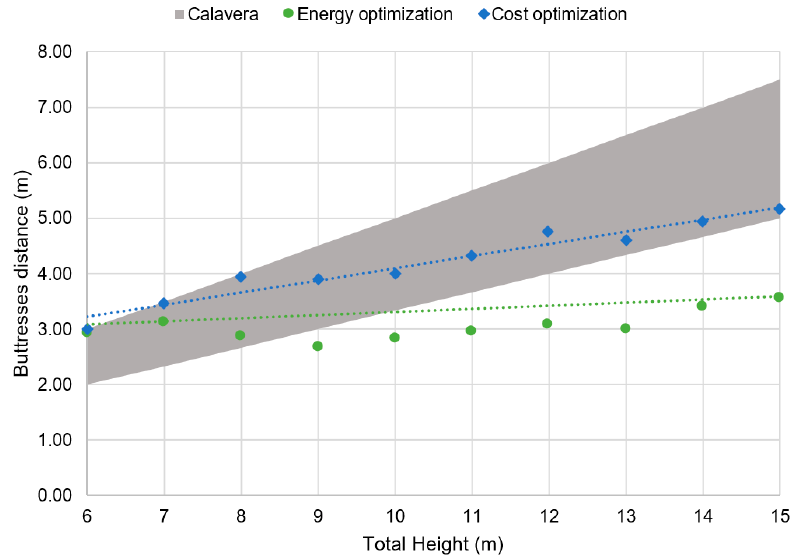
Figure 12. Relation between buttress distance and wall height.